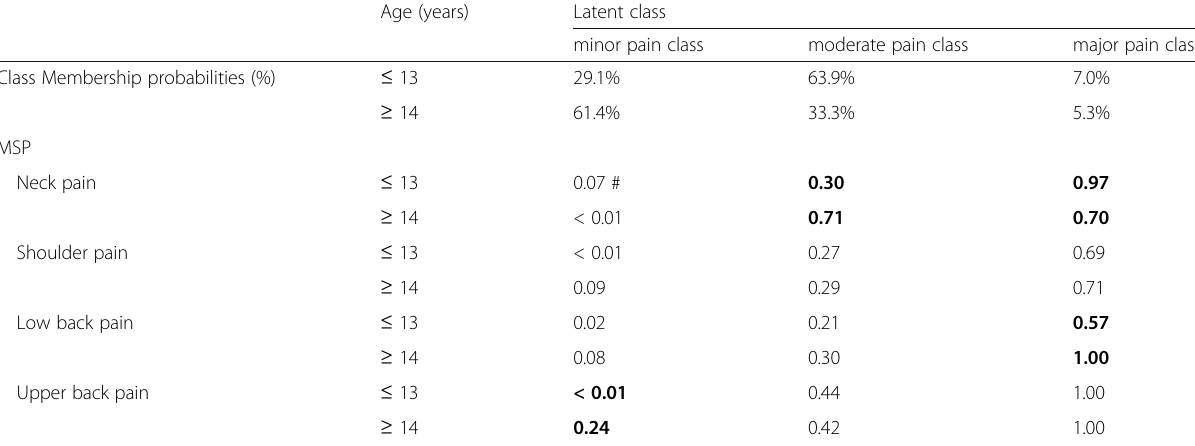
Table 4 Membership and item response probabilities in age-specific LCA